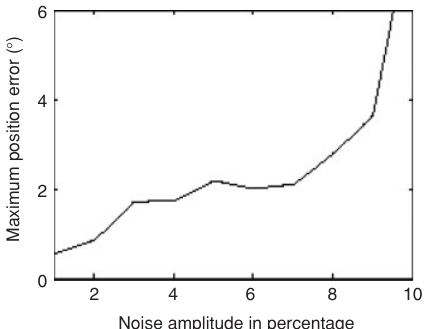
Figure 16 Fusion with soft sensor failure.